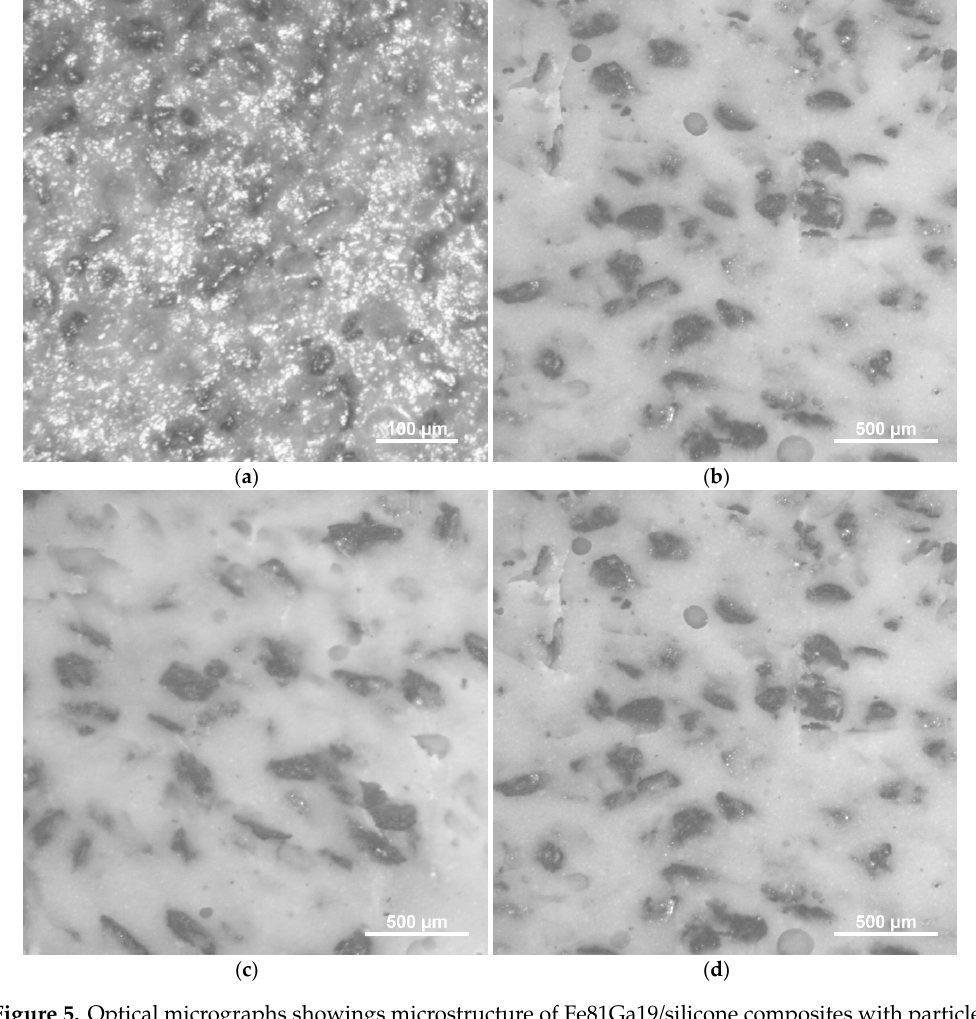
Figure 5. Optical micrographs showings microstructure of Fe81Ga19/silicone composites with particles size: ( a ) <50 µm and content of 45 wt.%; ( b ) 150–180 µm; ( c ) 180–250 µm; ( d ) > 250 µm and content of 60 wt.%.